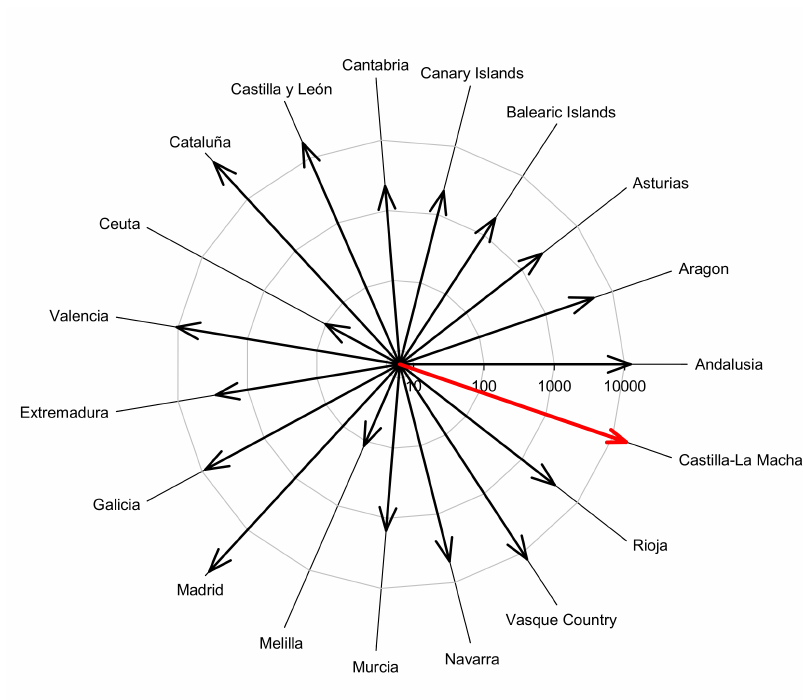
Figure 1. Number of cumulative deaths of COVID-19. Castilla-La Mancha was the third region with more COVID-19 cases in